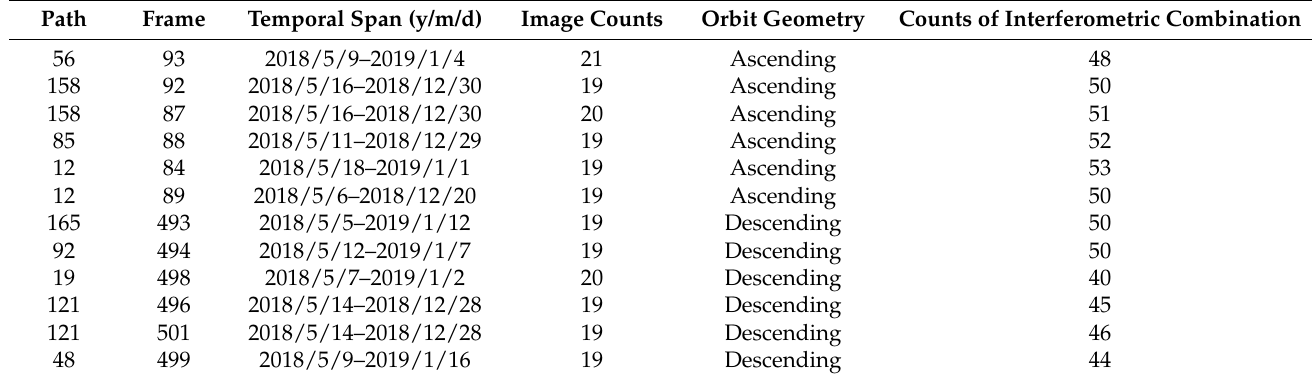
Table 1. Sentinel-1 data list used in the study area.